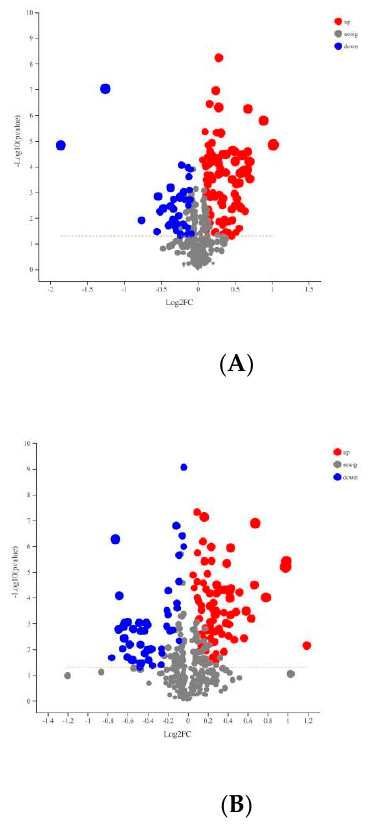
Figure 3. Volcano plots for the HE and. CON groups. ( A , B ) plasma samples analyzed in POS and NEG ion modes, respectively. Red and blue indicate, respectively, significantly upregulated and downregulated metabolites in the HE group compared with the CON group, and gray denotes no significant difference.